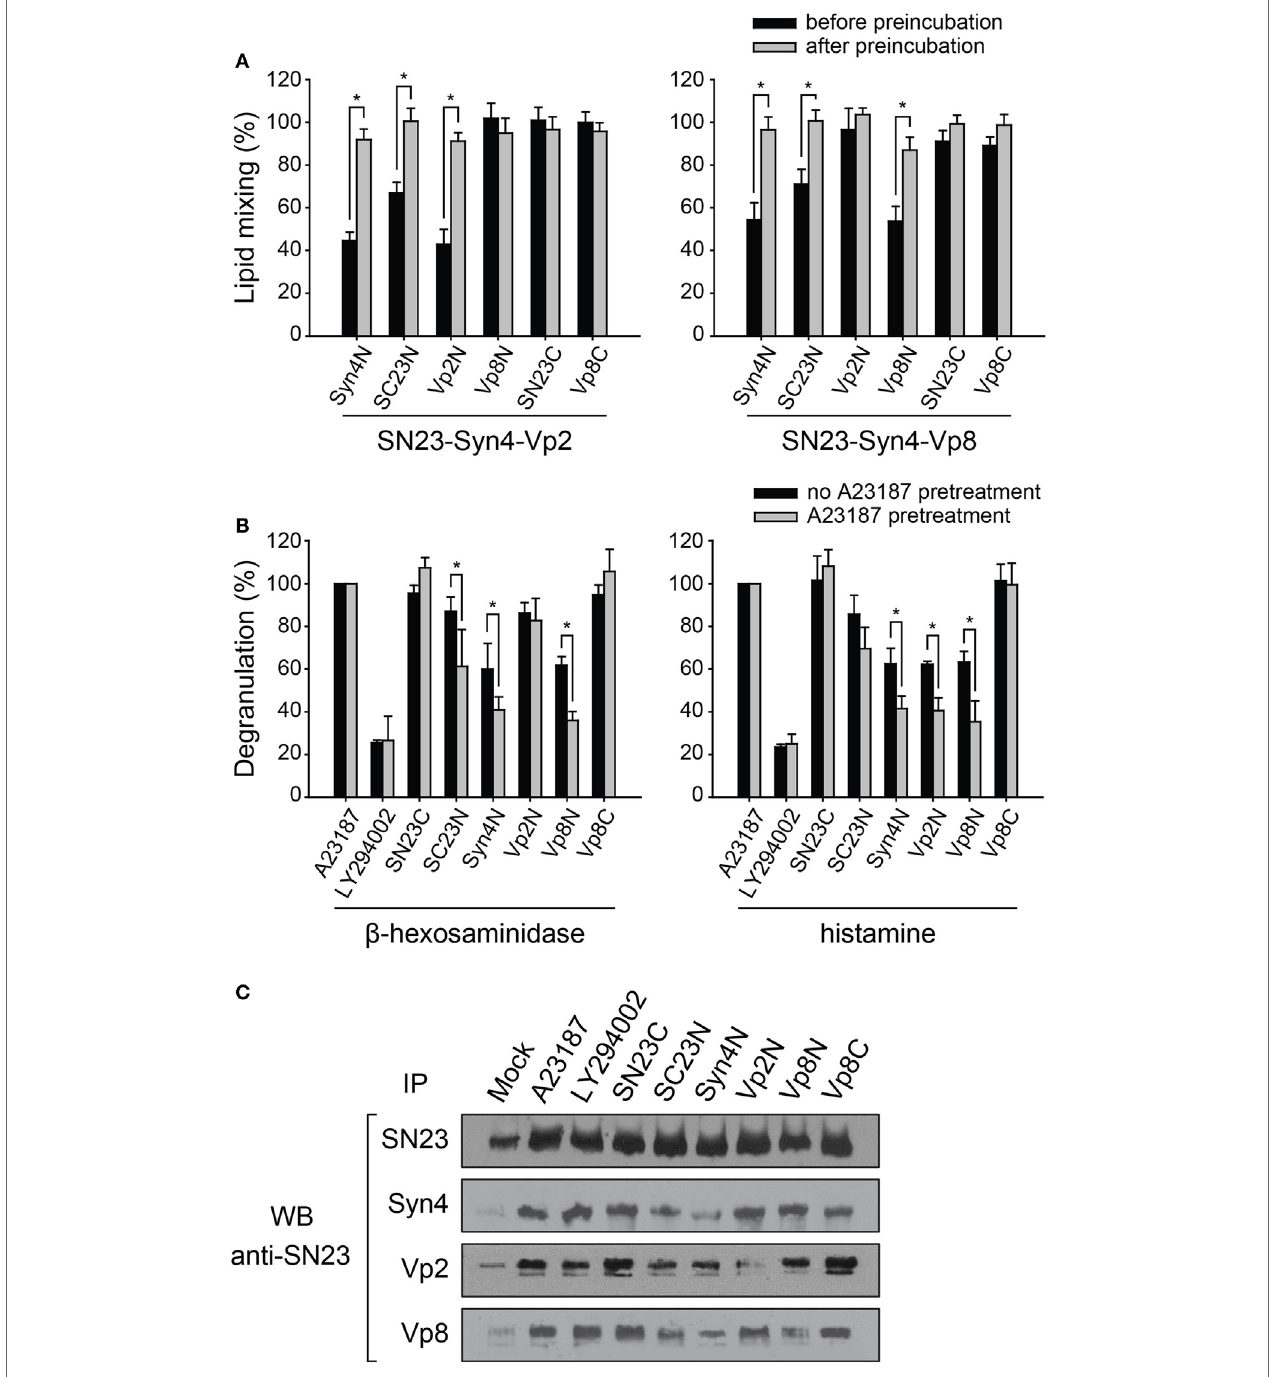
FigUre 4 | The inhibitory effect of synthetic peptides on the mast cell degranulation of distinct granule subsets. (a) Inhibitory effect of the N-terminal- mimicking peptides on membrane fusion dependent on the state of partial zippering of soluble N-ethylmaleimide-sensitive factor attachment protein receptor (SNARE) complex. The peptides were added before (black) or after the preincubation of T- and V-liposomes together at 4°C overnight (gray). Data are expressed as the mean ± SD. Significance: * p < 0.05. (b) The inhibitory effect of synthetic peptides on the degranulation of RBL-2H3 mast cells pretreated with A23187, which is an inducer of degranulation of mast cell without antigen-related Fc ε RI-crosslinking. After A23187 pretreatment, the mast cells were sensitized with DNP-IgE and then treated with protein transduction domain -conjugated peptides. The amounts of released granular components such as β -hexosaminidase and histamine were quantified by colorimetric biochemical assays. Data are expressed as the mean ± SD. Significance: * p < 0.05. (c) The extent of the formation of SNARE complexes in RBL-2H3 cells in the presence of inhibitory peptides was also examined by co-immunoprecipitation using an anti-SNAP-23